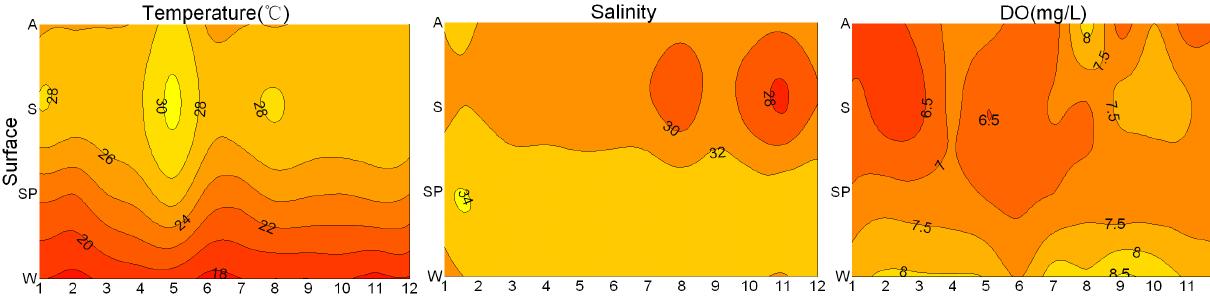
Figure 2. Changes of temperature, salinity and dissolved oxygen (DO) at the surface and bottom water (W: winter, SP: spring, S: summer, A: